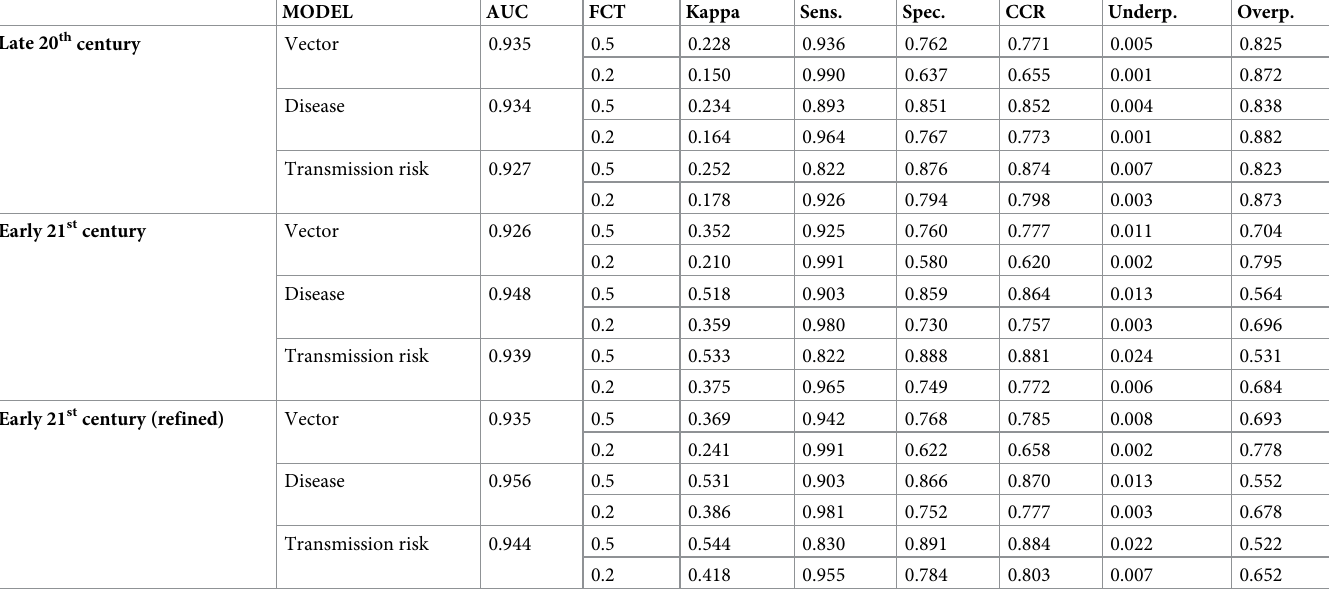
Table 1. Model assessment based on discrimination and classification capacities respect to vector and disease records of the same period. AUC: area under the receiver operator characteristic curve; FCT: favorability classification threshold; Kappa: Cohen’s kappa; Sens.: sensitivity; Spec.: specificity; CCR: correct classification rate; Underp.: underprediction rate; Overp.: overprediction